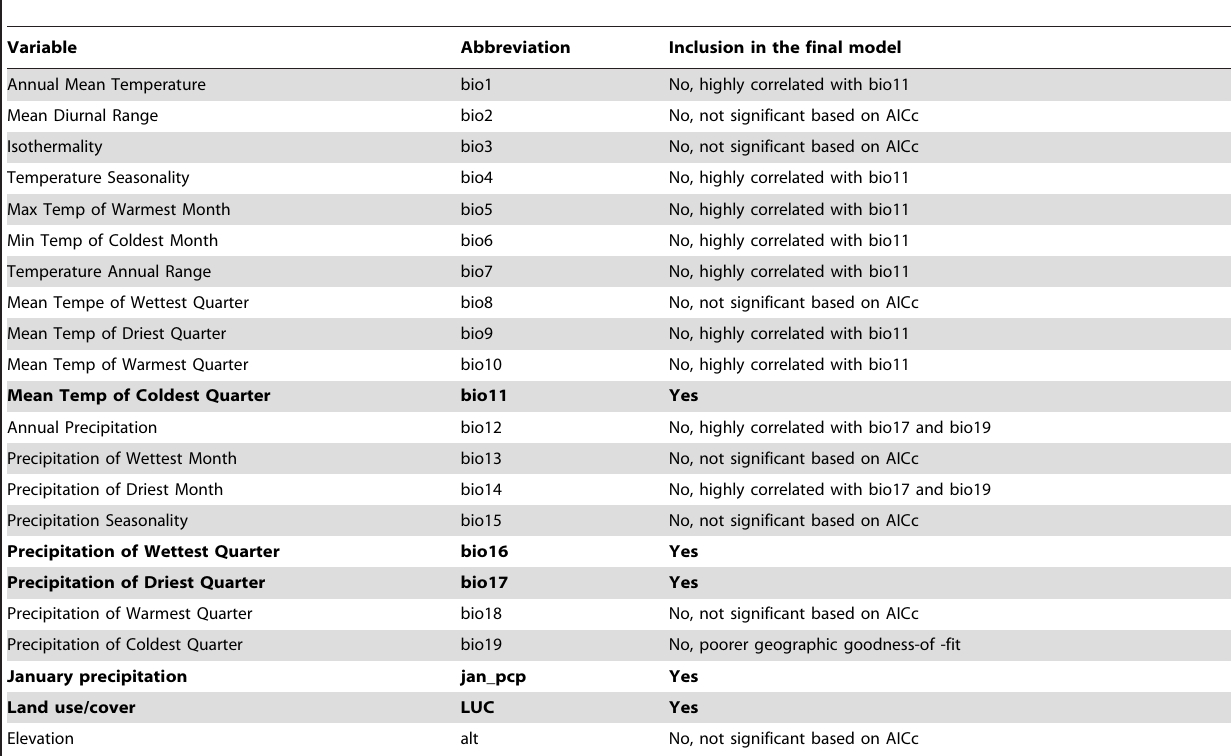
Table 1. Environmental variables used in the analysis and model selection. Variables included in the final model are indicated in